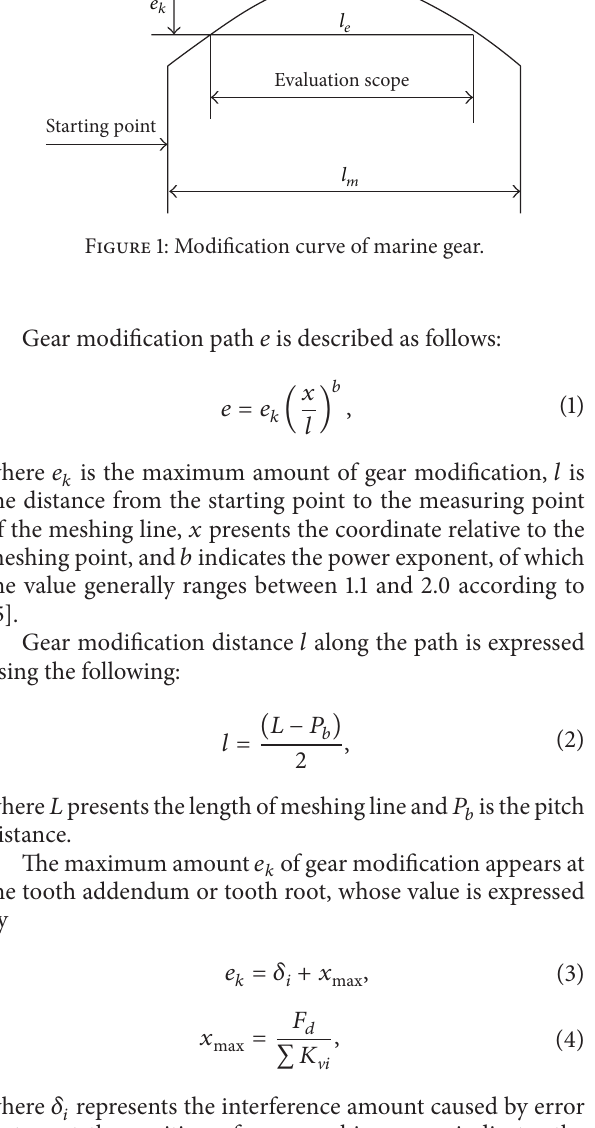
Table 1: Gear parameters of one-level